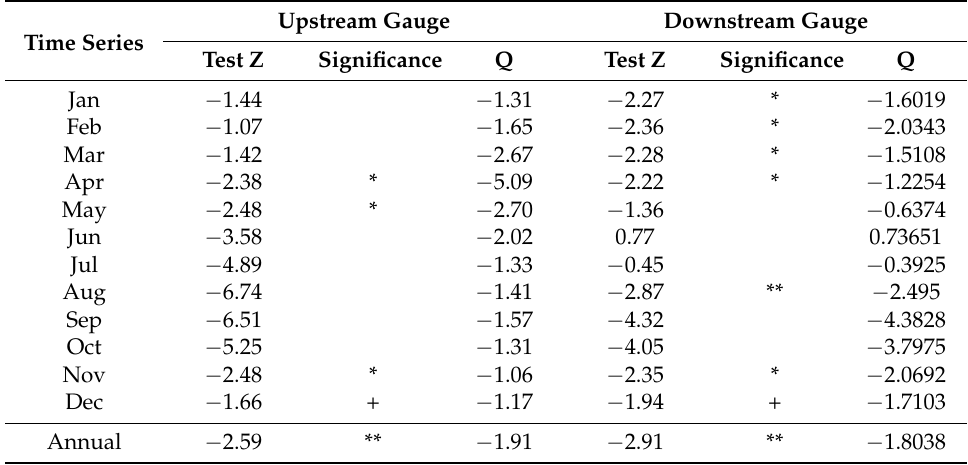
Table 2. Trends in monthly and mean annual river flow obtained using Sen’s slope and Mann–Kendall trend test located up- and down-stream of Dukan